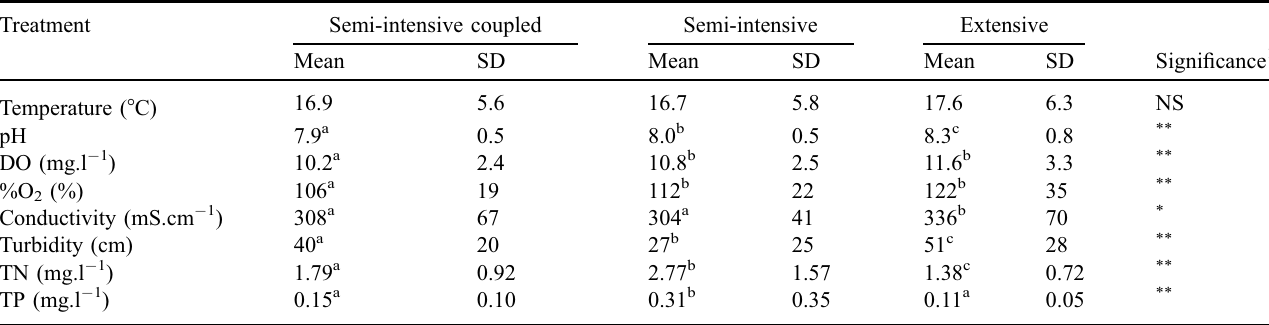
Table 3. Means (and standard deviations (SD)) of physicochemical parameters of fi shpond water recorded weekly (temperature, pH, DO: dissolved oxygen, %O 2 : oxygen saturation, conductivity and turbidity) or monthly (TN: total nitrogen, TP: total phosphorus) from March- December.